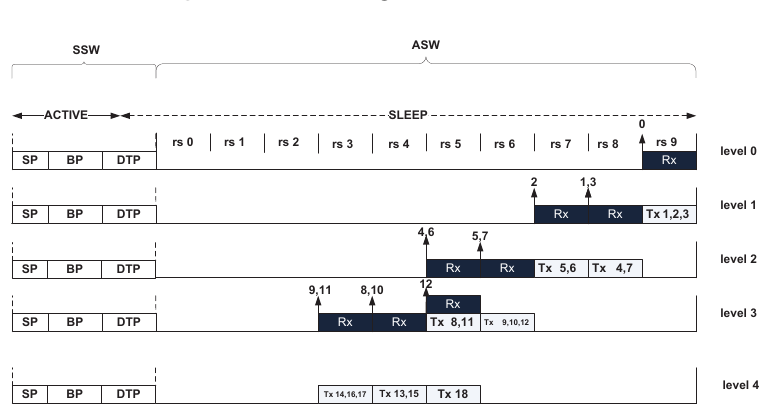
Figure 6. Slot assignment of